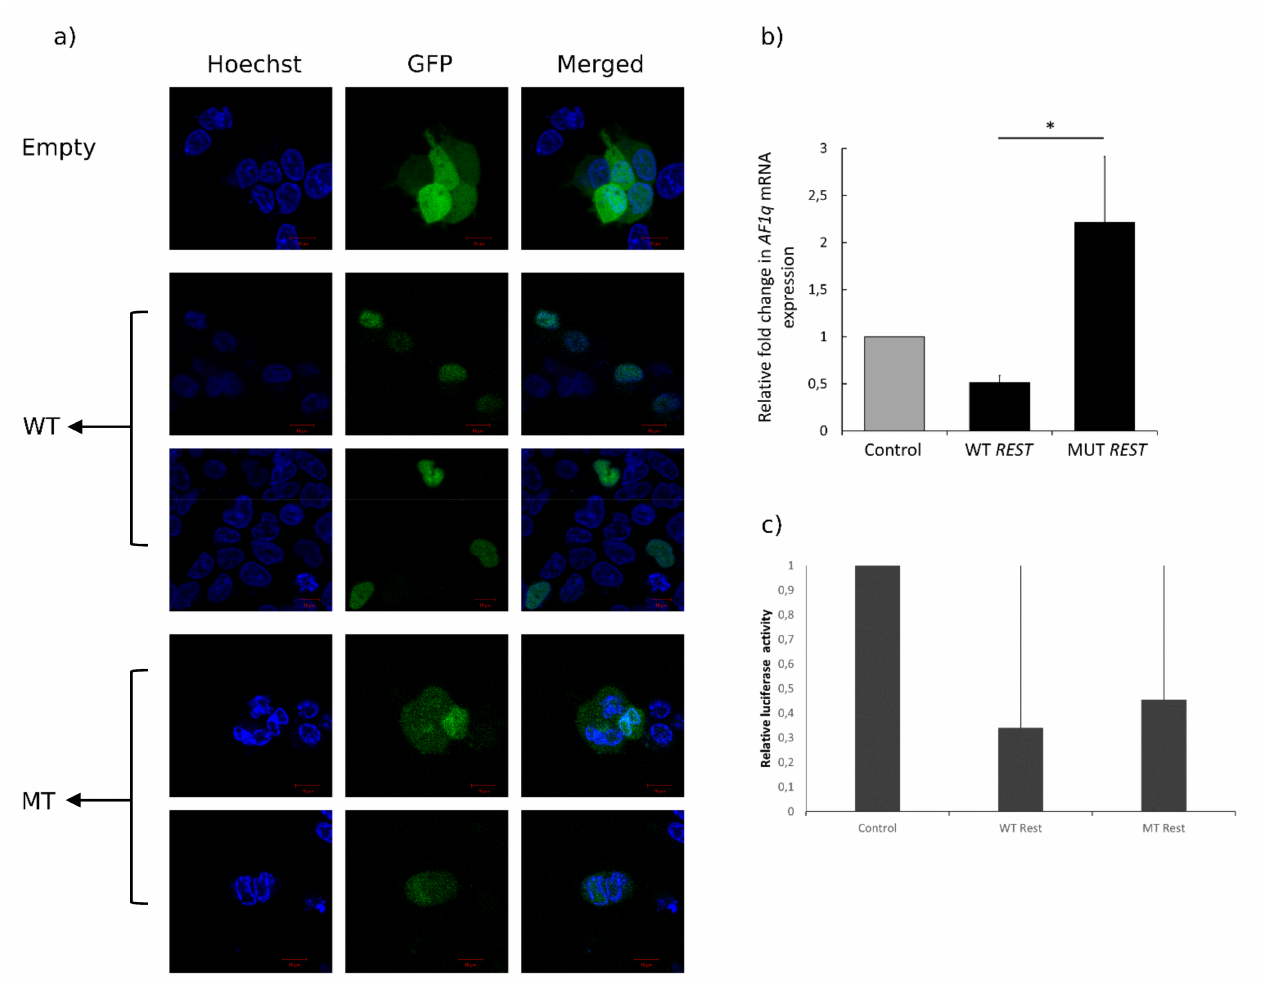
Figure 3. WT REST localizes to the nucleus, while MT REST displays localization patterns similar to GFP-only and loses repressive ability of target gene. ( a ) Micrographs of HEK-293 cells transfected with GFP-only (one representative image), GFP-tagged WT REST and GFP-tagged MT REST (two representative images each). The LHS row indicates Hoechst staining, the middle row indicates GFP, and the RHS row represents merged images. HEK-293 cells were transiently transfected with the respective constructs and visualized live after 24 h (spiked with Hoechst stain) under the confocal microscope ( b ) HEK-293 cells were transiently transfected with WT or MT REST expression constructs, and 24 h later the expression of AF1q mRNA was measured using qPCR and plotted relative to empty vector control. ( c ) HEK-293 cells were transiently transfected with WT and MT REST expression constructs and harvested and lysed 36 h later. Luciferase activity was measured with a luminometer and plotted relative to the empty vector